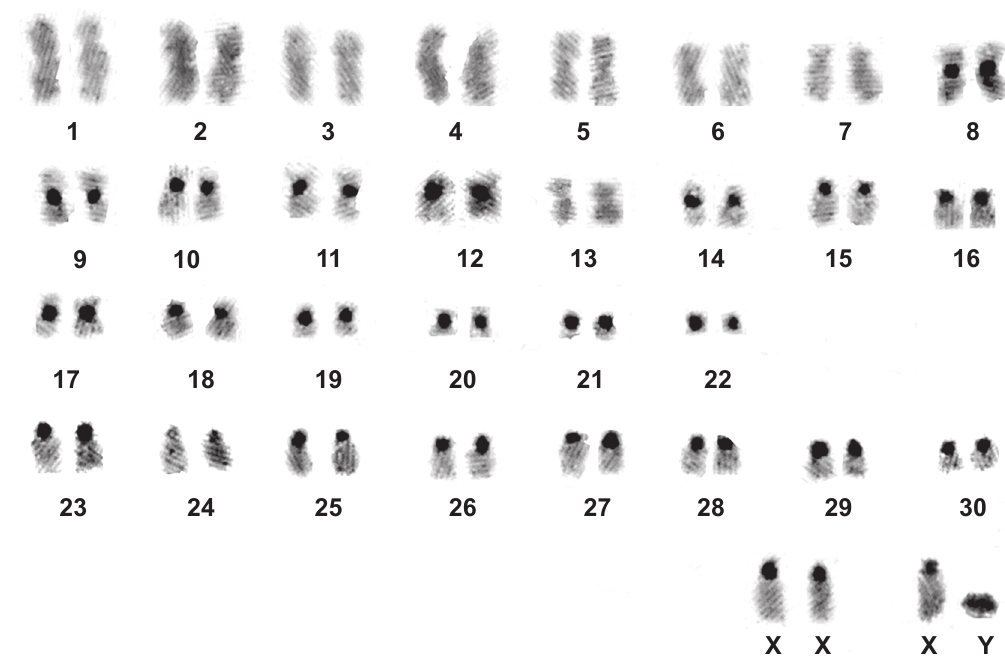
Figure 3. Chromosomes of W. pyrrhorhinus from Fazenda Salinas, Morro do Chapéu, Bahia: C-banded karyotype of a female and the sex chromosomes of a male. Scale bar = 10 µm.